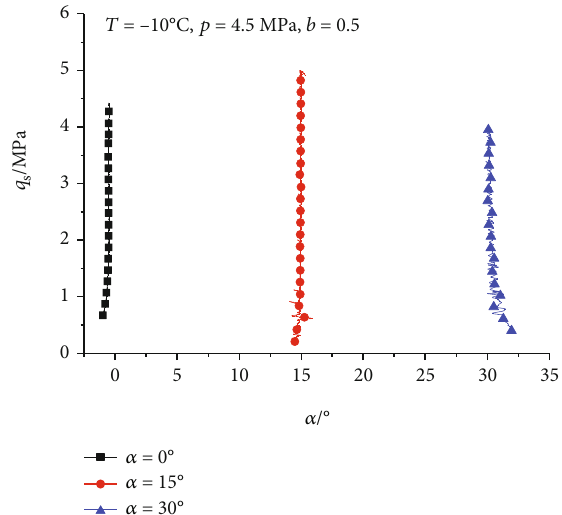
Figure 6: Stress path under di ff erent mean principal stresses.